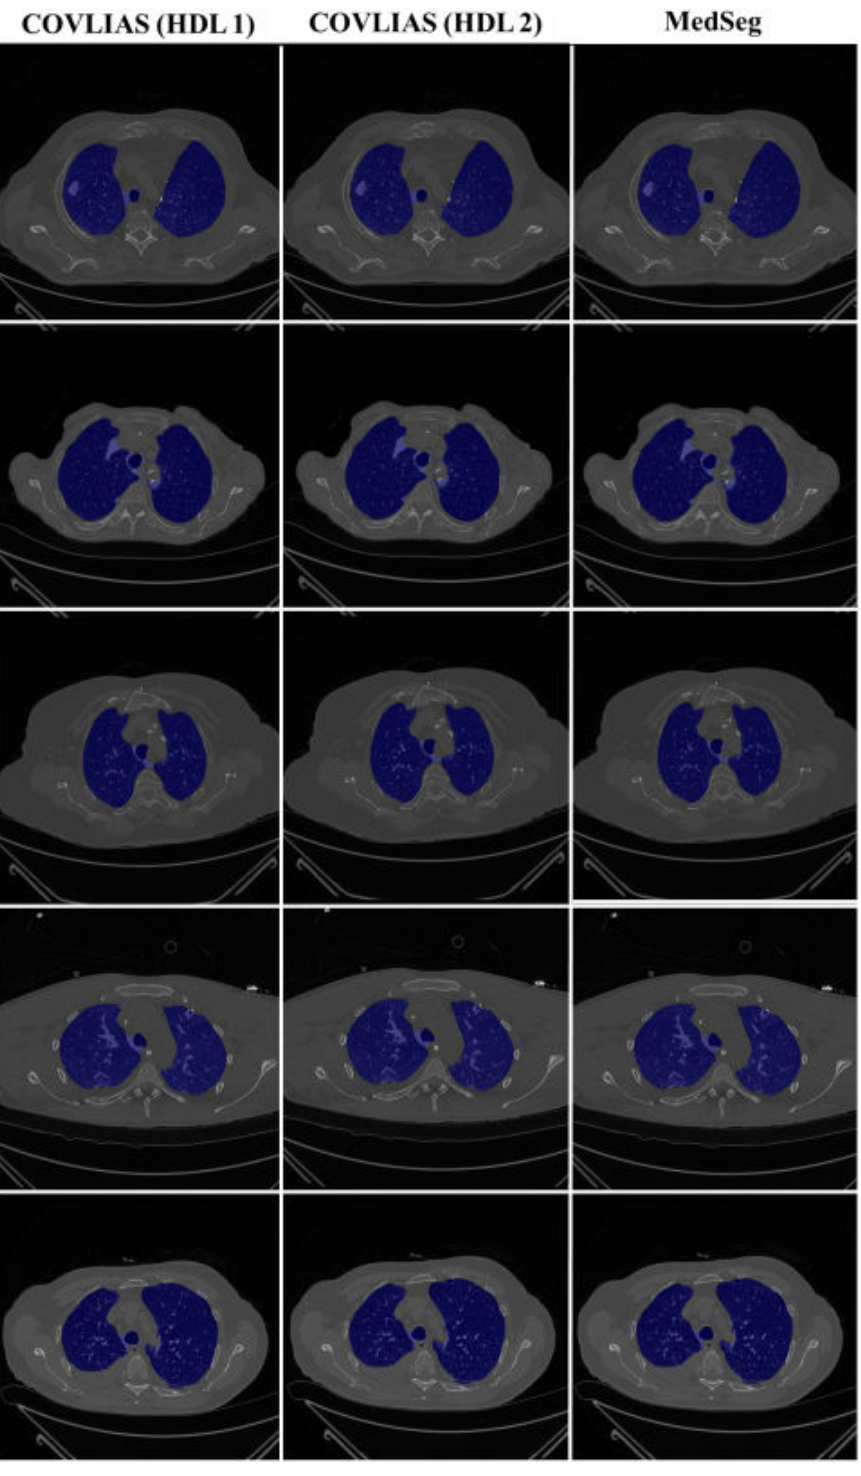
Figure 24. COVLIAS vs. MedSeg: Segmented mask (blue) on the non-COVID CT lung image (small